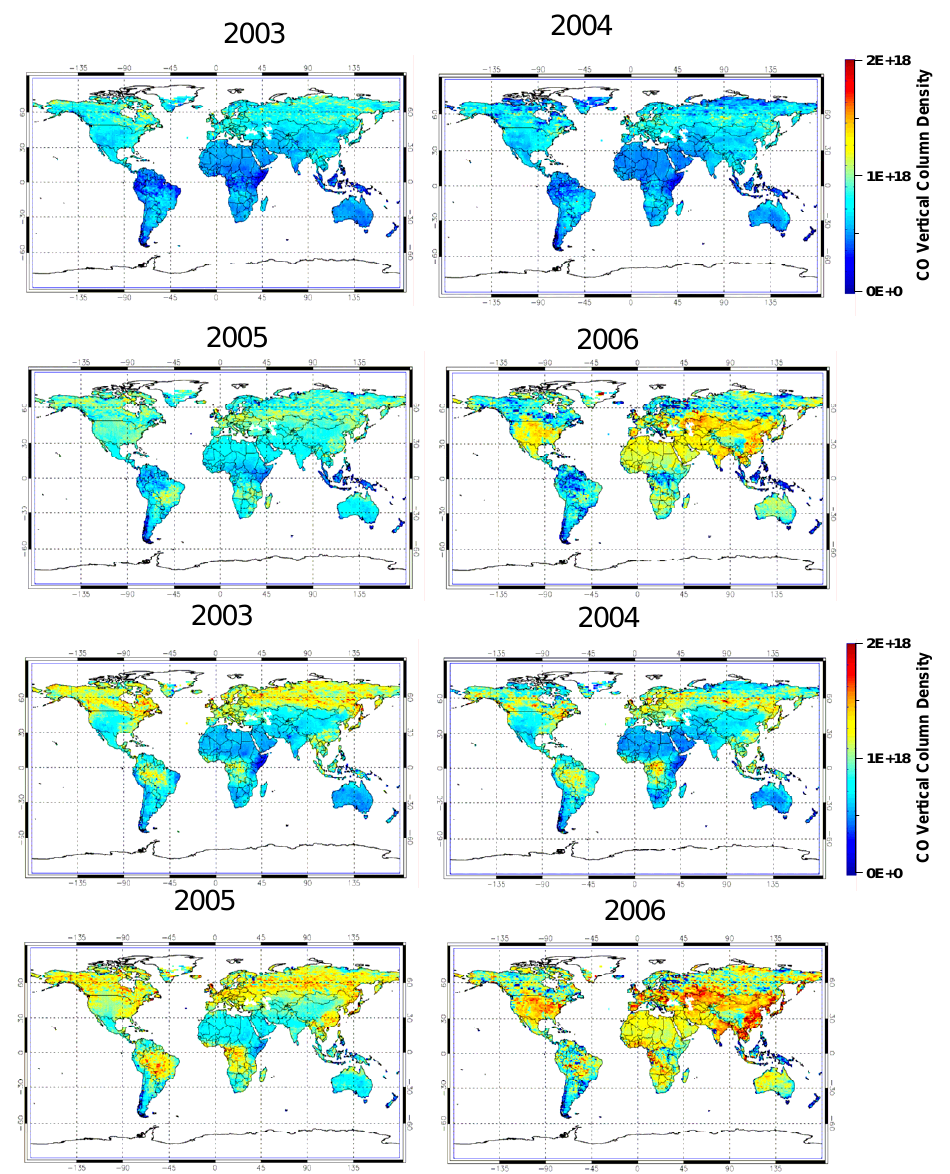
Fig. A2. Differences of the SCIAMACHY CO VCD for the different steps of our retrieval. Top: SCIA CO VCD with MOPITT normalisation minus MOPITT normalisation without MOPITT normalisation. Bottom: SCIA CO VCD with MOPITT normalisation and cloud correction minus MOPITT normalisation without MOPITT